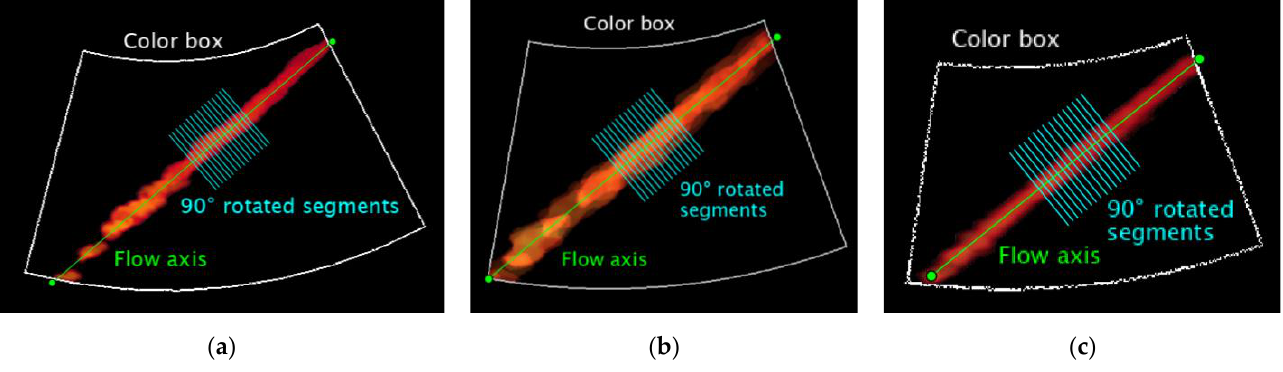
Figure 6. Ninety-degree rotated segments automatically drawn on the i -th average image for ( a ) system one, ( b ) system two and ( c ) system three equipped with convex array probes in configuration B at 7.0 mL·s −1 .